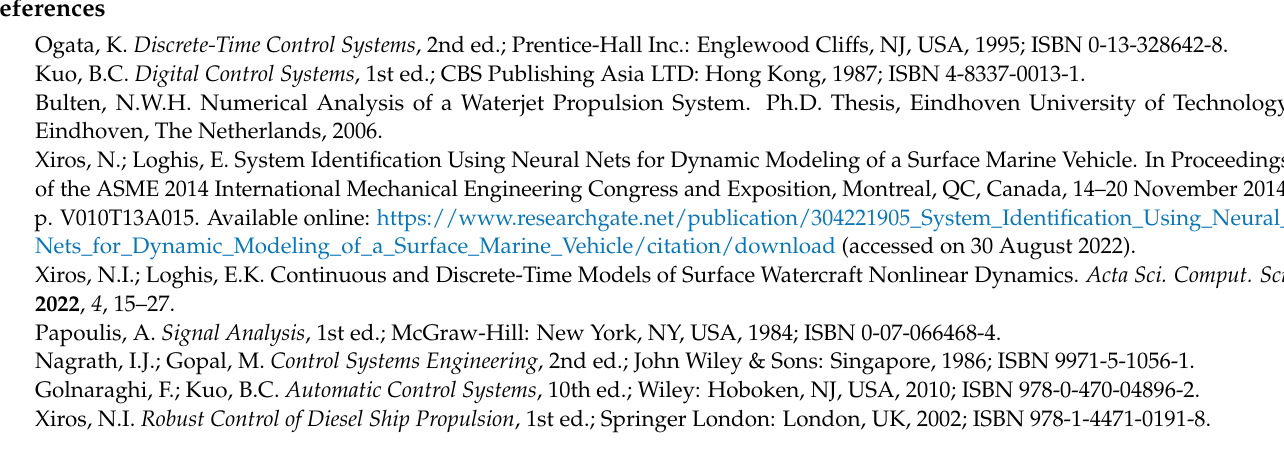
Figure A3. Closed-loop thrust ( a ) and brake power ( b ) experimental results. Finally, it was found that the brake power values calculated on the basis of waterjet thrust measurements were in satisfactory agreement. Consequently, the propulsion powertrain model developed was safely used for further design, control and integration studies.